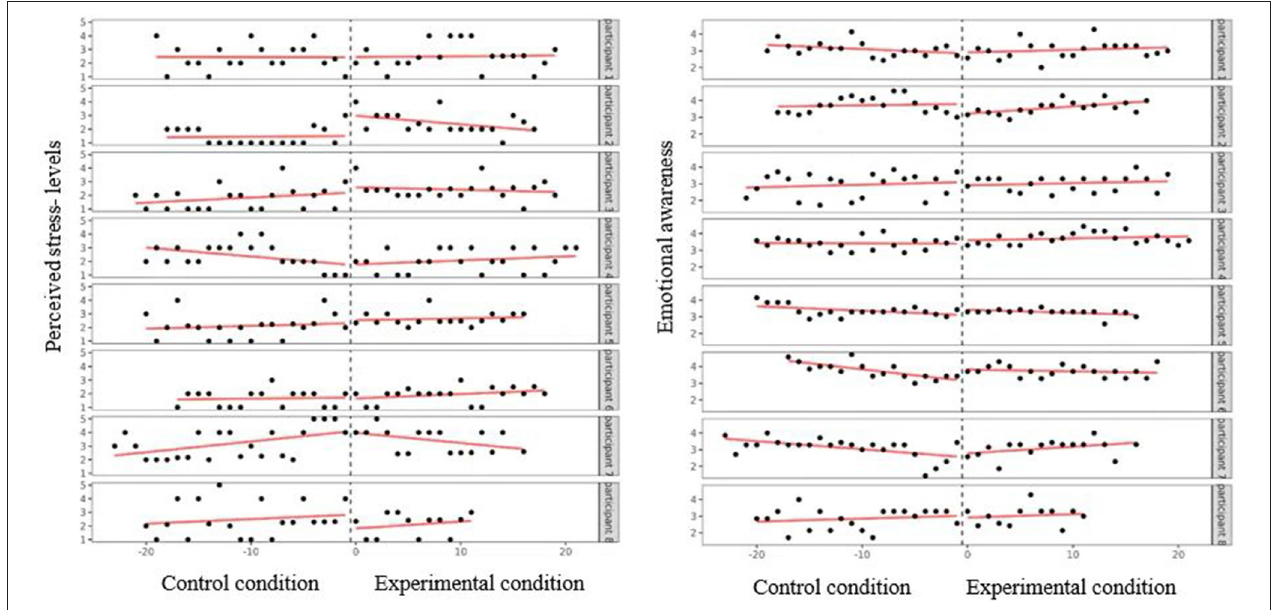
FIGURE 2 | Perceived stress-levels (left) and emotional awareness (right) as a function of condition and measuring time per